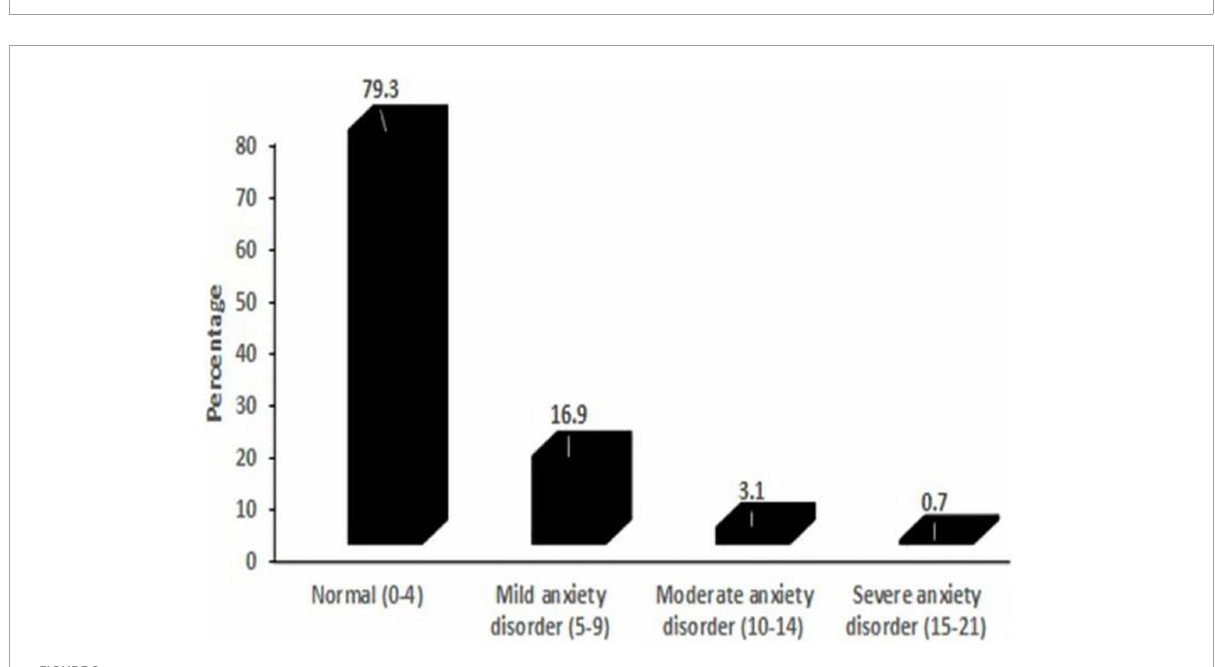
FIGURE2 Prevalence of anxiety symptoms among tabacco users during COVID-19